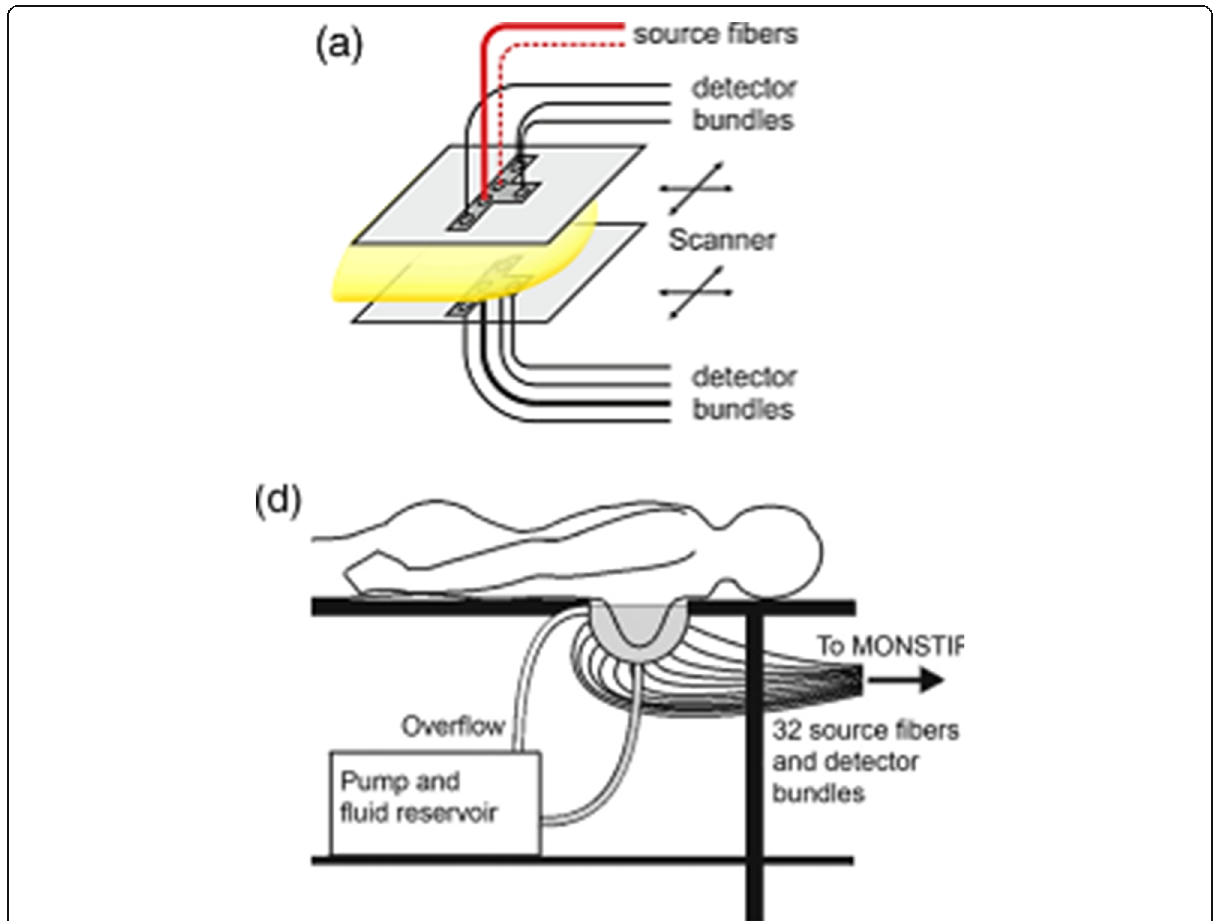
Fig. 21 Optical imaging method with breast tissue compression